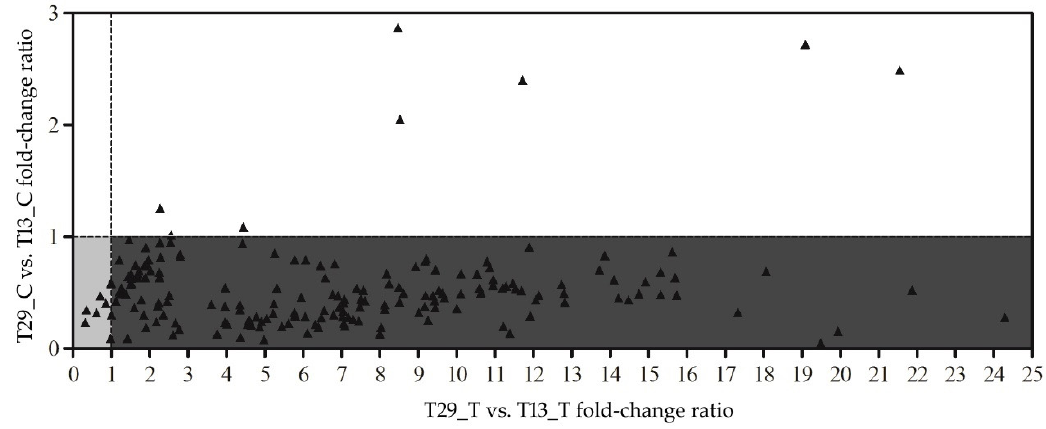
Figure 5. Scatter plot comparing the relative ratio of treatment-to-control fold-changes in expression between high-NUE T29 and low-NUE T13 across the 187 downregulated differently expressed genes unique to the T13_T vs. T13_C. y < 1 T29 control showed lower expression relative to T13 control, x > 1 T29 treatment showed higher expression relative to T13 treatment. Numbers greater than 25 are not shown. The gray portion of the graph represents the stress-tolerance genes and the dark portion represents relatively upregulated